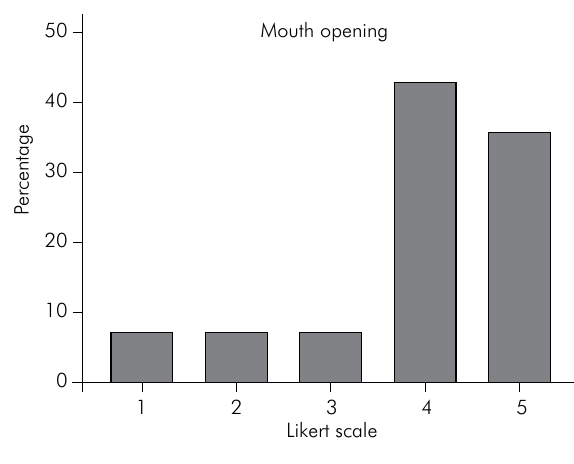
Figure 2. Frequency of values in the Likert scale as to the